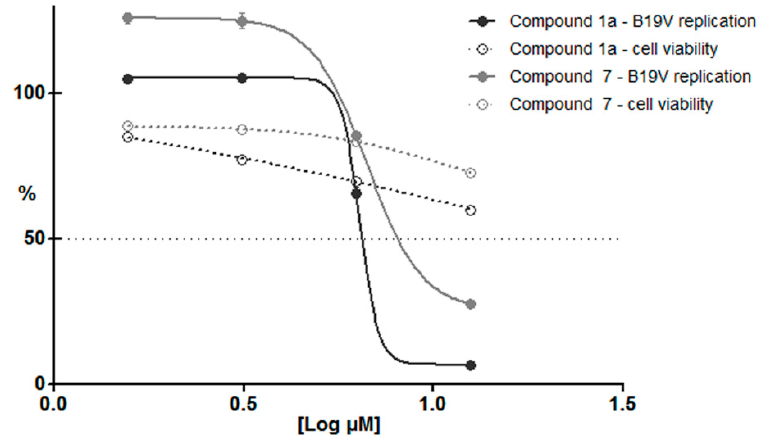
Figure 5. Viral replication and cell viability, normalized response to compounds 1a and 7 in UT7/EpoS1 cells. Normalized dose-response curves were calculated from qPCR and CCK8 assay data, obtained at 48 hpi for the different experimental series and expressed as percentage values compared to control samples (DMSO 1%).